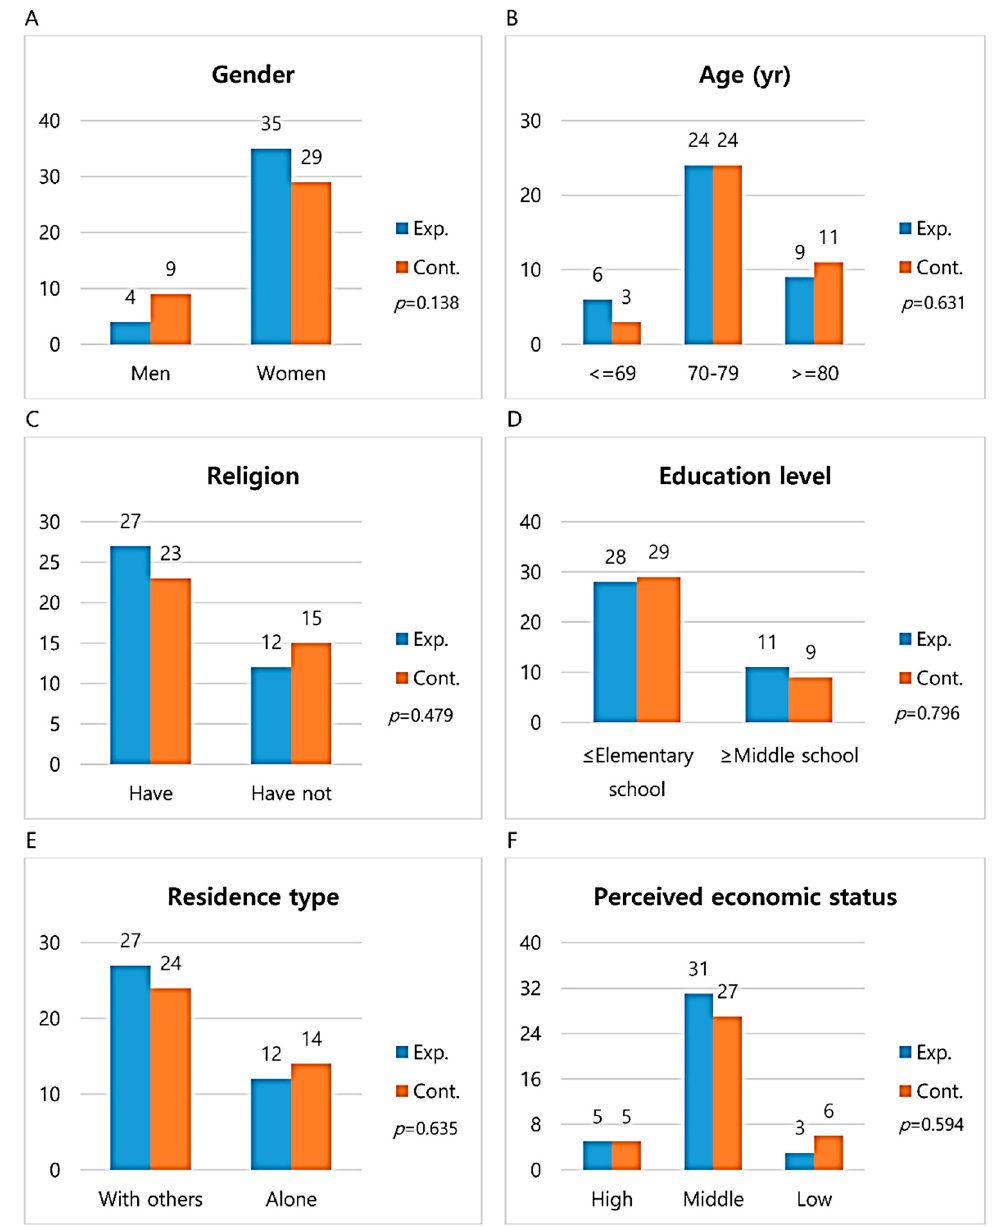
Figure 2. Homogeneity of general characteristics between two groups. ( a ) No significant difference in gender ( χ 2 = 2.47). ( b ) No significance difference in age ( χ 2 = 1.18). ( c ) No significance difference in religion ( χ 2 = 0.64). ( d ) No significance difference in education level ( χ 2 = 0.21). ( e ) No significance difference in residence type ( χ 2 = 0.32). ( f ) No significance difference in perceived economic status ( χ 2 = 1.26). Significance level was set to 0.05. Exp. = Experimental group; Cont. = Control group .